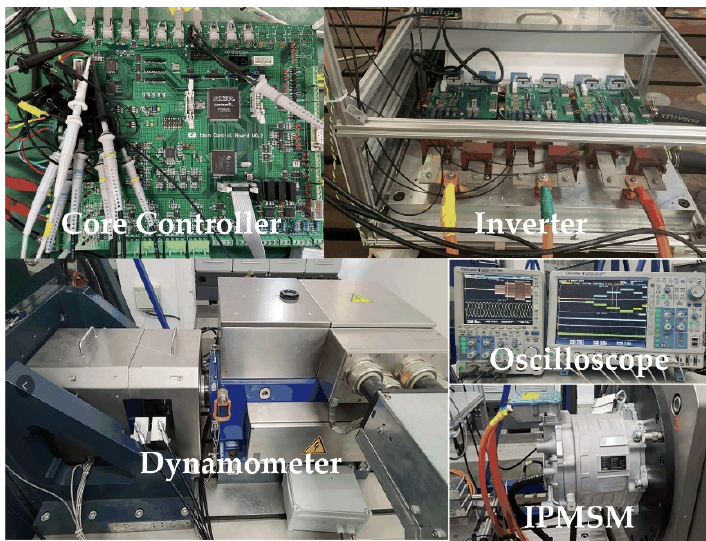
Figure 4. Block diagram of the whole proposed control scheme.